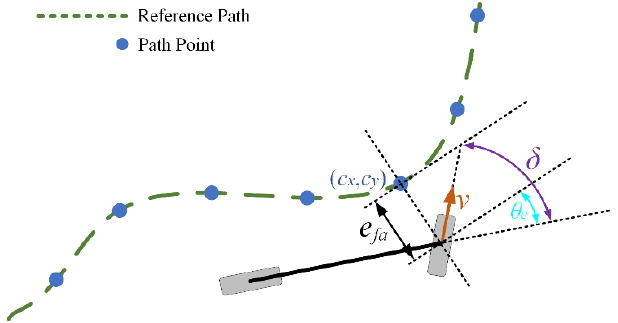
Figure 2. Geometric analysis of Stanley